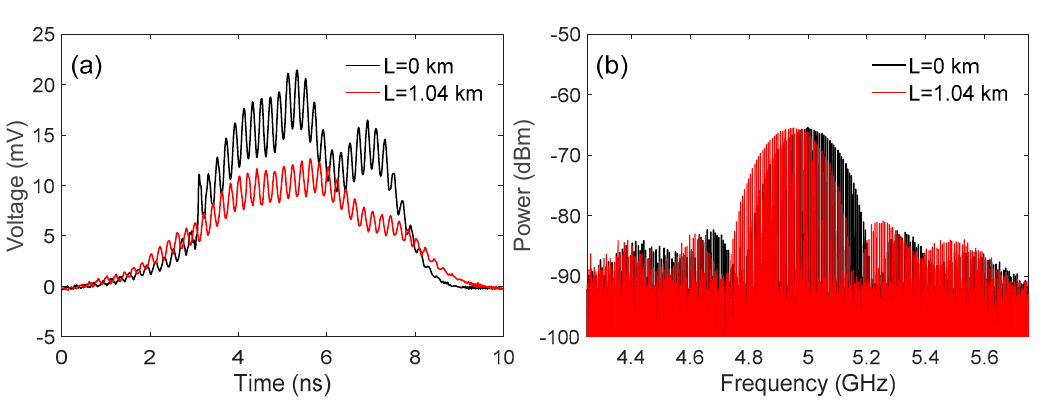
Figure 6. ( a ) The optical spectrum of the WSL; ( b ) the time domain signal of the WSL beating signal after the PD (the inset is the zoom-in of the pulse shape from 0.349 ns to 0.362 ns).